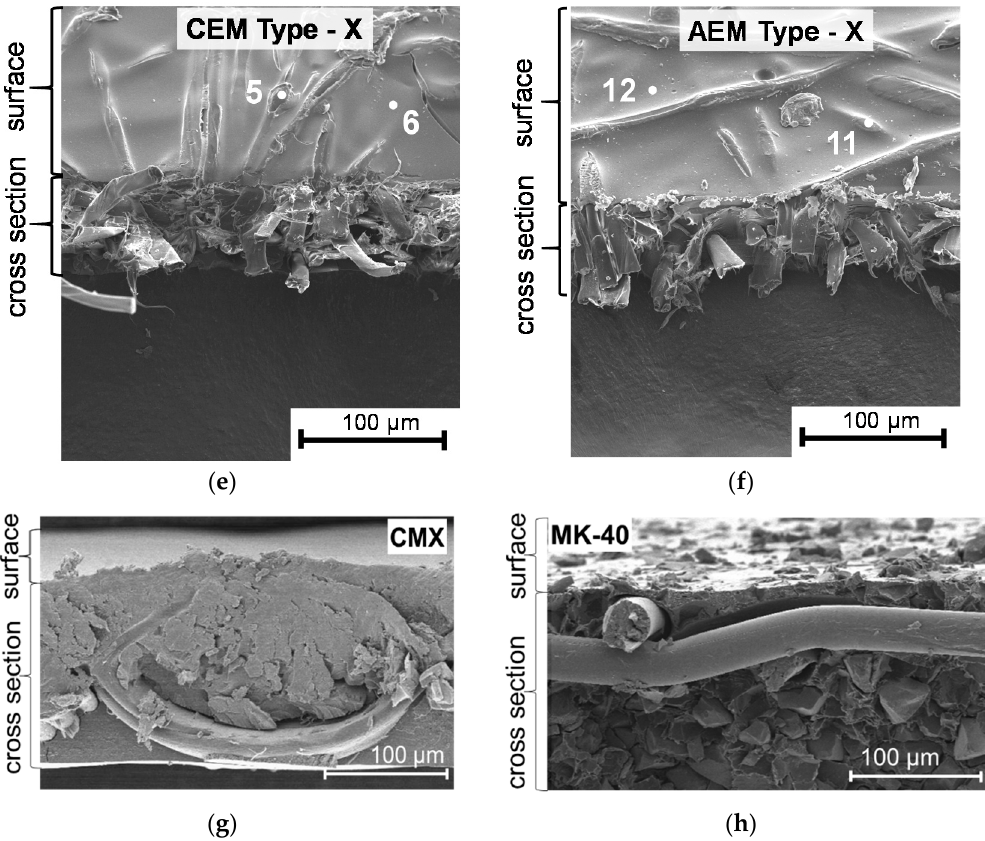
Figure 2. SEM images of the surface and cross sections of cation-exchange ( a , c , e ) and anion-exchange ( b , d , f ) IEM, manufactured using the electrospinning method, as well as Neosepta CMX ( g ) and heterogeneous MK-40 ( h ) membranes. The places where the element analysis was performed using the XRF are marked with white points.